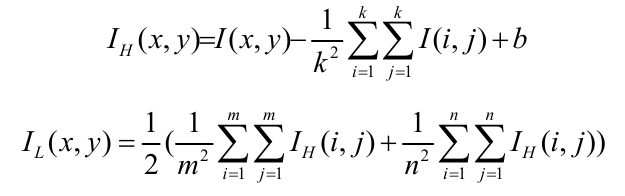
Figure 4. Effect of image processing on SIFT: ( a ) Original; ( b ) After